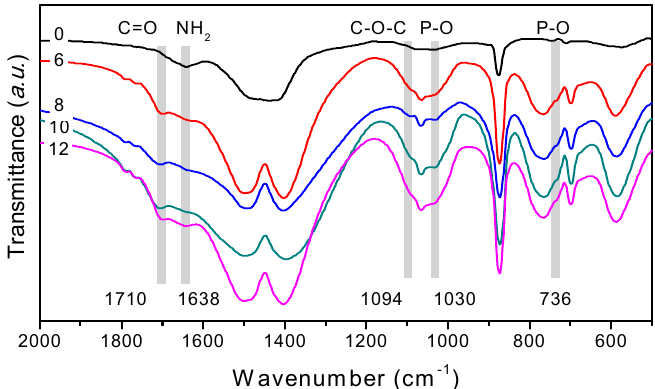
Figure 11. Fourier transform infrared analyses of the organic functional groups from biominerals at different Mg/Ca ratios.